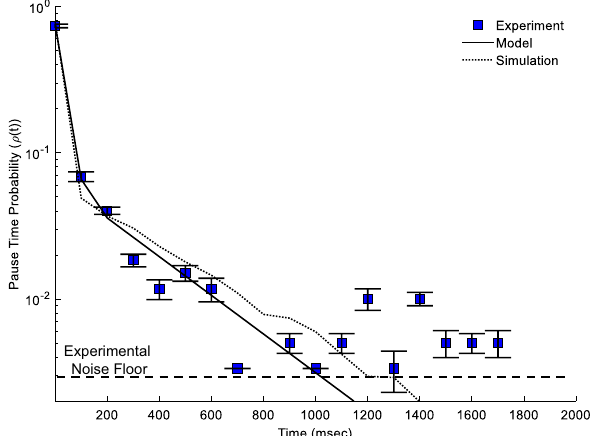
Figure 5. Retrograde-driven transport pause distribution as a function of time. The SVP traverse fraction (t = 0 ms) is included along with the model fit at that data point for context. Experimental data shows a decrease in pause-time probability with increasing time (Blue squares, N = 599. Both the analytical model (Eq. 1, solid line, Pd = 0.35) and the coarse-grained computational simulation (dashed line, Pd = 0.35) reproduce the observed experimental results. The lower-limit of pause-time fraction used to fit to the model was the gaussian random noise (1/Number of SVPs, “Experimental Noise Floor”, dashed